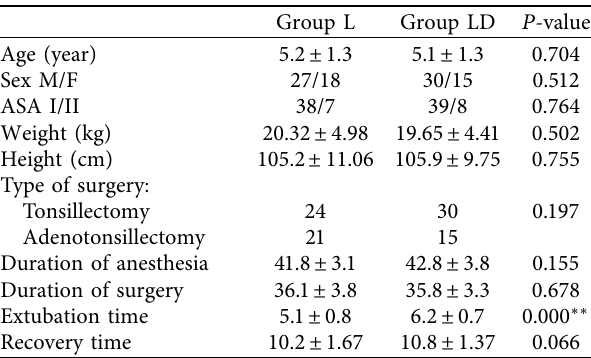
Table 1: Demographic data, surgery type, duration of anesthesia, and extubation